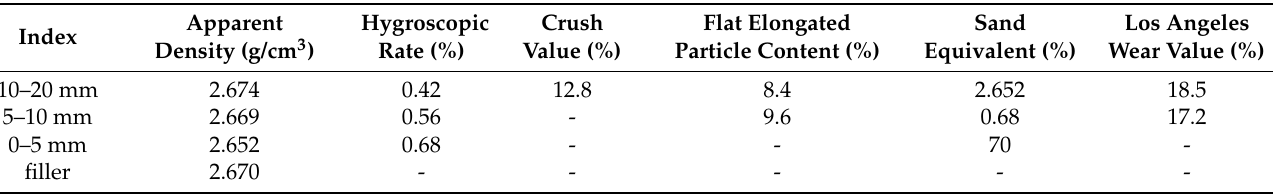
Table 3. Test results on physical properties of natural